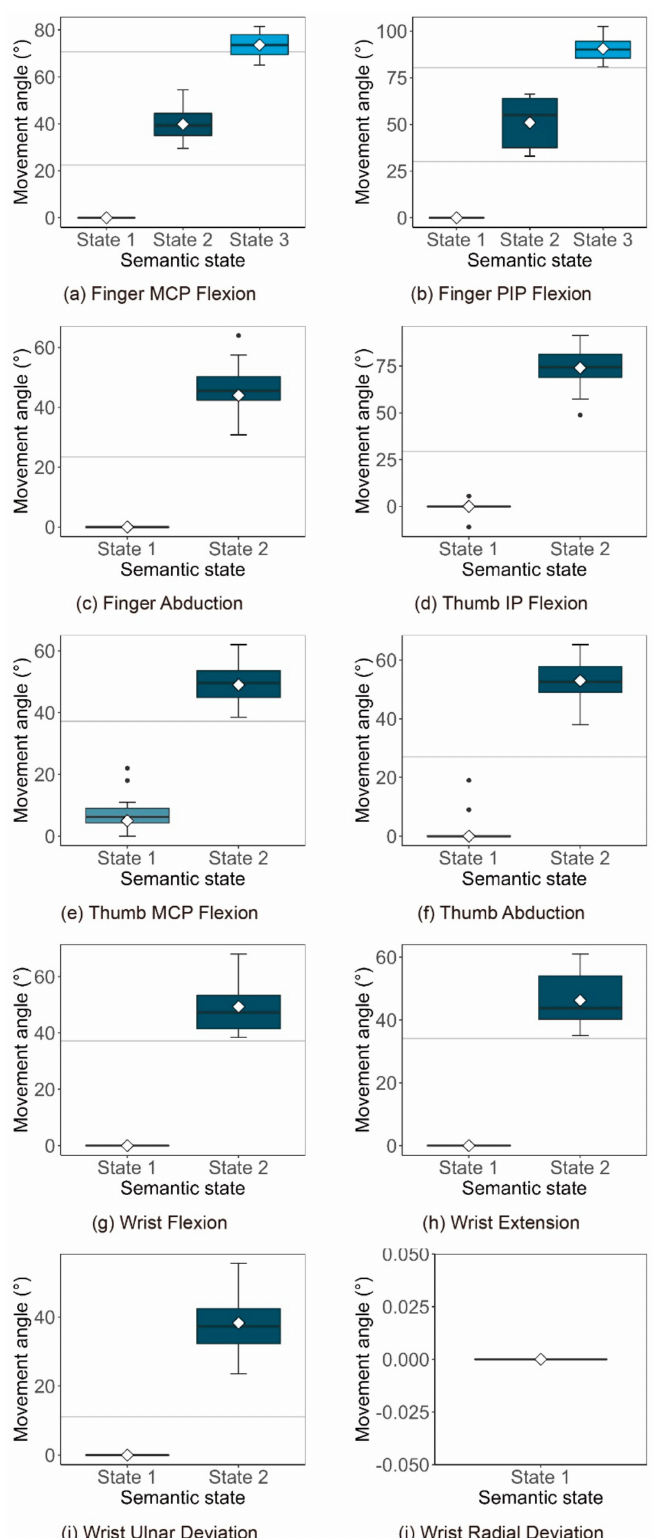
Figure 12. The distribution diagram of the execution angle measurement data of each motion primitive unit semantic state. For each chart, the state name of each motion primitive unit represents the vertical coordinate, while the motion angle of the corresponding motion primitive unit is the horizontal coordinate. Additionally, the horizontal reference lines are the boundary line of the semantic state of each motion primitive unit obtained in Experiments 1 and 2, and the diamonds in the box plot are the mean points of the data corresponding to each state after eliminating